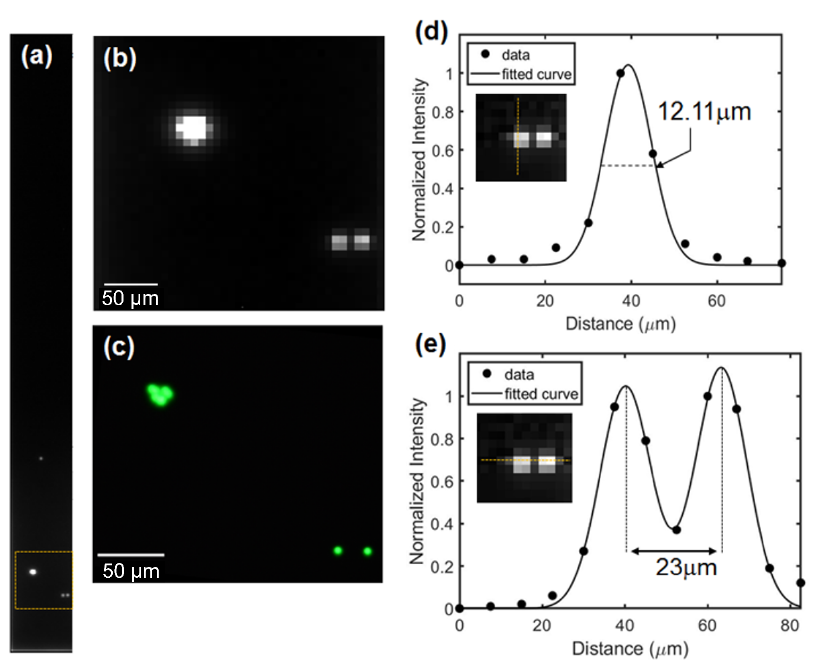
Figure 5. ( a ) Photograph of the microbead emission captured by the needle sensor. ( b ) Enlarged image of the ROI, denoted with a yellow square on ( a ) the merged beads in the upper left corner and the separated beads in the lower right corner; this image is compared with the microscope image ( c ). ( d ) Single-microbead emission intensity in the vertical direction, plotted and fitted with the Gaussian distribution. The FWHM is 12.11 µm. ( e ) Two close microbeads can be distinguished, as the distance between them is almost twice the